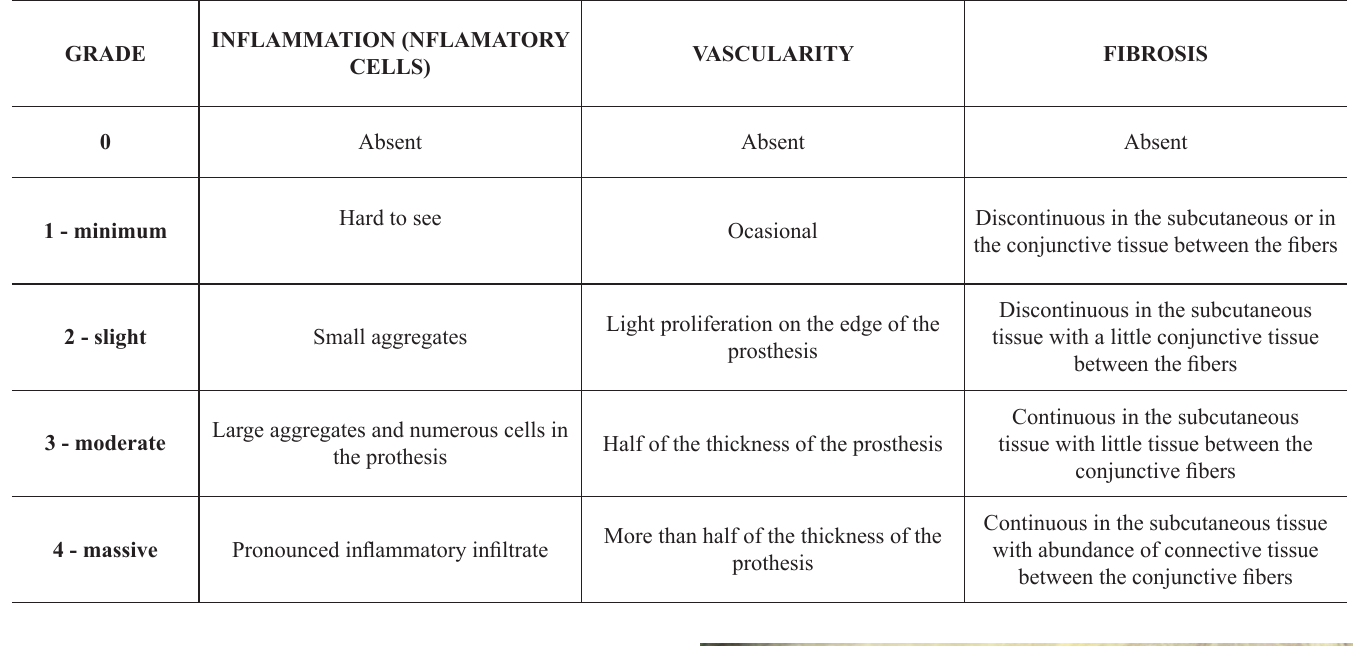
TABLE 2 - Histopathological semiquantitative grading scale.